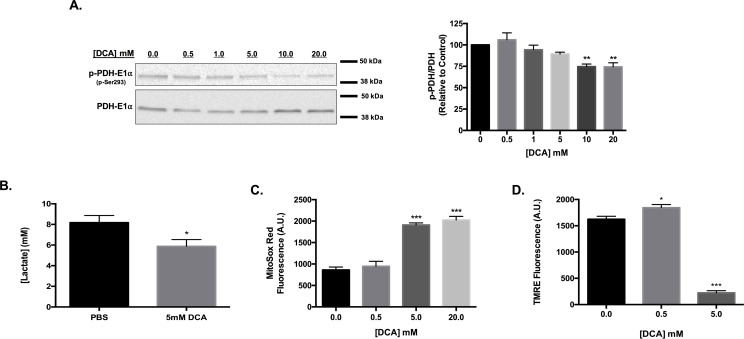
DCA promotes superoxide production and dissipation of ΔΨm in VM-M3 cells.(a) Western blot analysis of p-PDH-E1α (Ser293) and PDH-E1α in VM-M3 lysates following 4-hour treatment with DCA. Densitometric ratio of p-PDH to PDH was determined for each treatment relative to PBS control. (b) Quantification of lactate concentration in culture medium following 24-hour incubation with indicated treatment. (c) Quantification of average MitoSox Red fluorescence intensity as an indication of VM-M3 superoxide production following 1-hour incubation with DCA. (d) Quantification of average tetramethylrhodamine (TMRE) fluorescence intensity as an indication of mitochondrial membrane potential following 4-hour DCA treatment. (b) Error bars represent standard error of the mean (SEM) of three experimental replicates. (c-d) Error bars represent SEM of a single experiment replicated in triplicate; * p<0.05, and ***p<0.001.